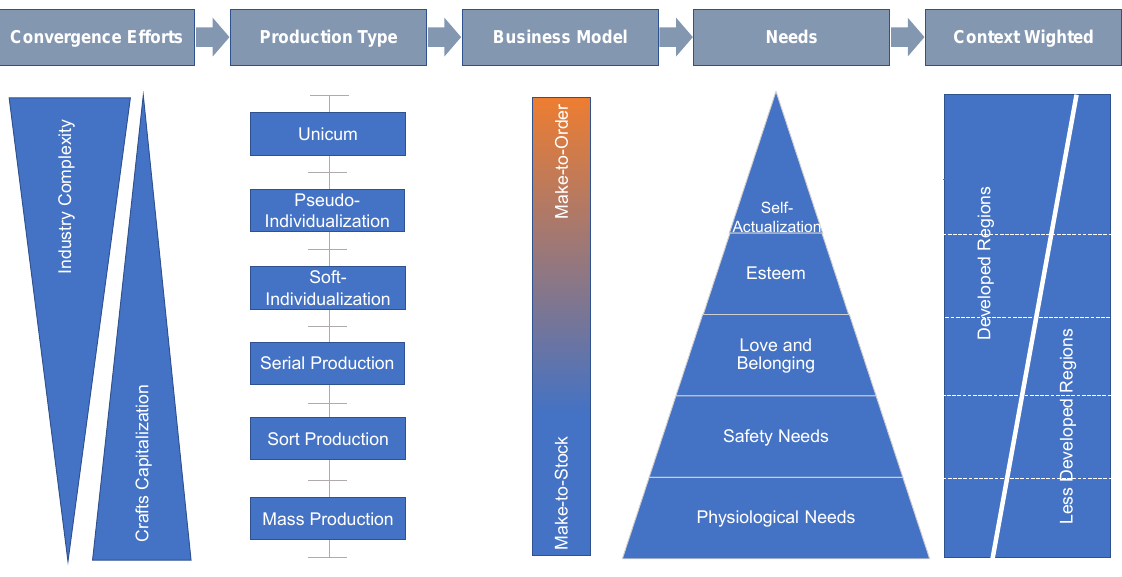
Figure 4 . Convergence Aspects from Production and Demand